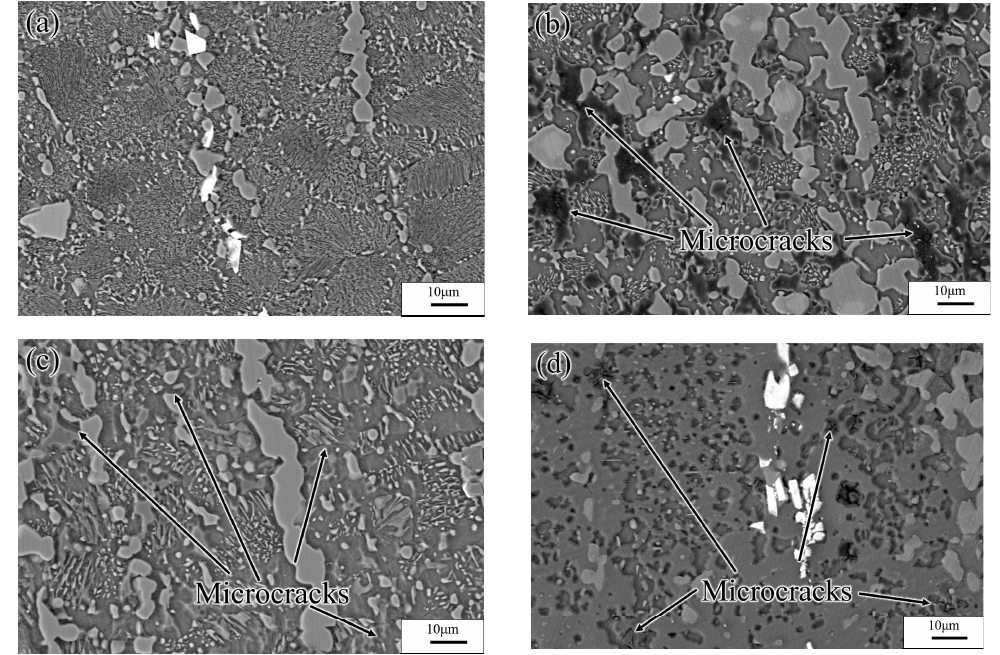
Figure 22. SEM images of Mg-16Al Mg alloy in INS: ( a ) 523 K/0.0001 s − 1 , ( b )573 K/0.0001 s − 1 , ( c ) 623 K/0.0001 s − 1 , and ( d ) 673 K/0.0001 s − 1 .